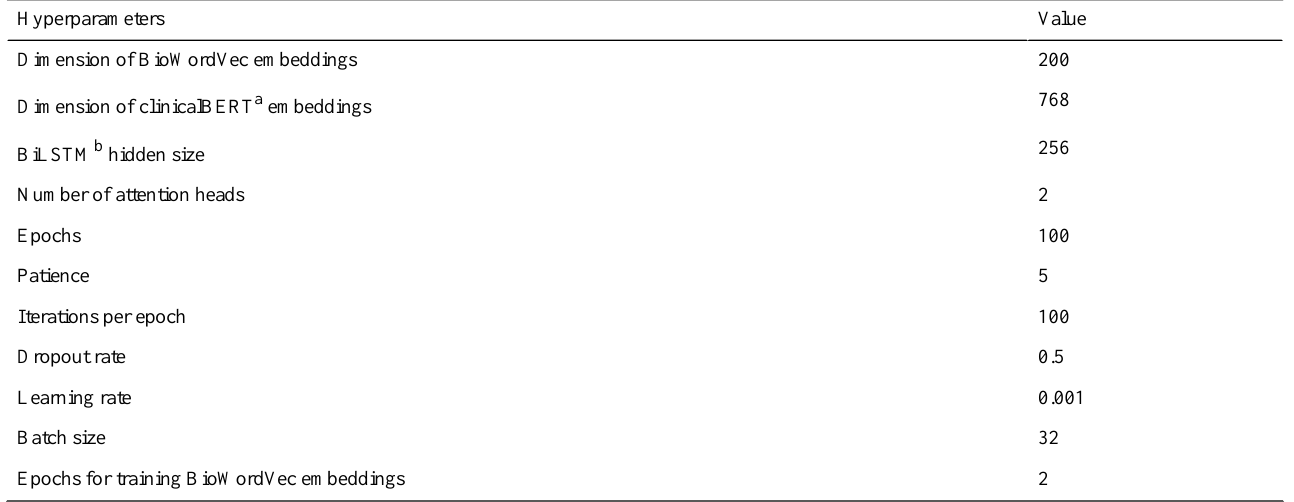
Table 2. List of hyperparameters used for deep learning model